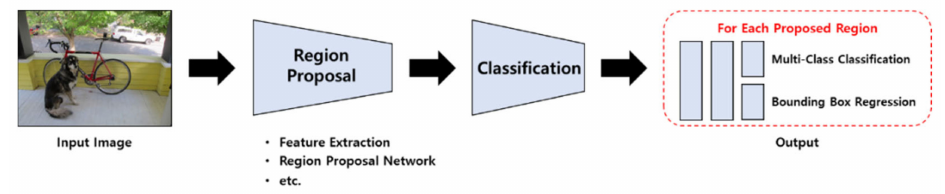
Figure 2. Two-stage detector image processing process.